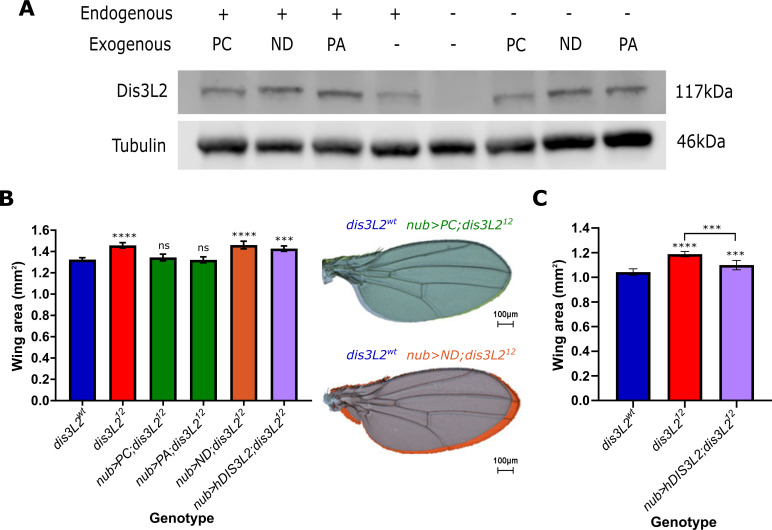
Ectopic expression of catalytically active dis3L2 rescues the wing overgrowth phenotype.A)
UAS-dis3L2PA, UAS-dis3L2PC, or UAS-dis3L2ND can be used to express Dis3L2 in dis3L212 animals. UAS constructs were driven in either dis3L2wt (+) or dis3L212 (-) animals with the ubiquitous driver act-GAL4 with Western blots performed on whole female flies. See S2A Fig for quantification. B) Expression of both Dis3L2 isoforms (PC) or only the shorter isoform (PA) in the wing pouch of the wing imaginal disc is sufficient to completely rescue wing area in dis3L212 mutants. Expression of a catalytically dead Dis3L2 (ND) does not rescue the phenotype, whilst expression of human DIS3L2 (hDIS3L2) also shows no significant rescue at 25°C. n = 14–65, error bars represent 95% CI, statistics shown refer to a comparison between the test genotype and control **** = p<0.0001, *** = p<0.001, ns = p>0.05. C) When driven at 29°C the human DIS3L2 construct (hDIS3L2) shows a partial (~50%) rescue of wing area. n = 16–28, error bars represent 95% CI, **** = p<0.0001, *** = p<0.001.